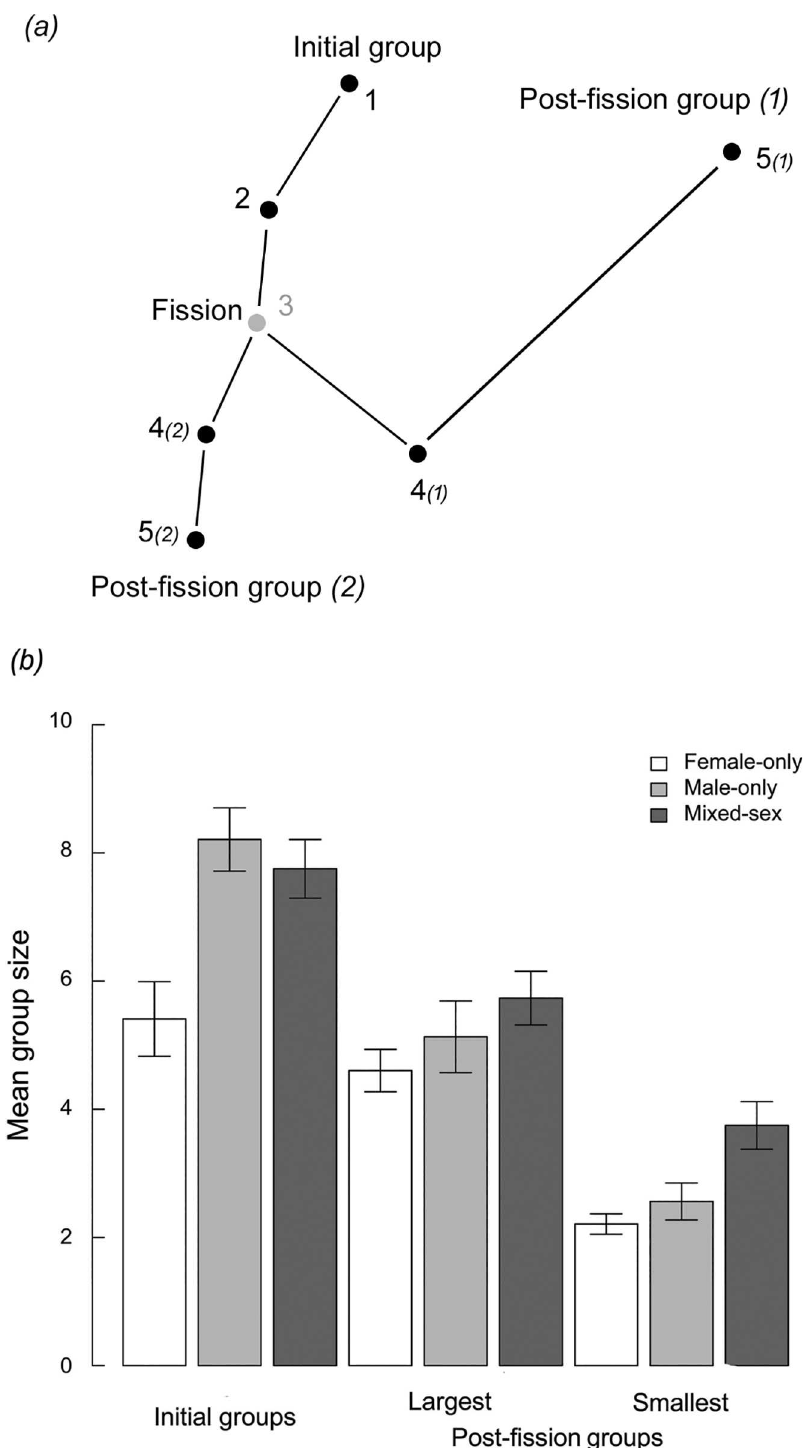
Fig 1. Features of fission events. (a) Exampleof fission event showingthe time-scale (from 1 to 5) at which variation of mean group size and net squareddisplacement were studied and (b) mean group size ( ± SE) of initial and post-fissiongroupsaccordingto group